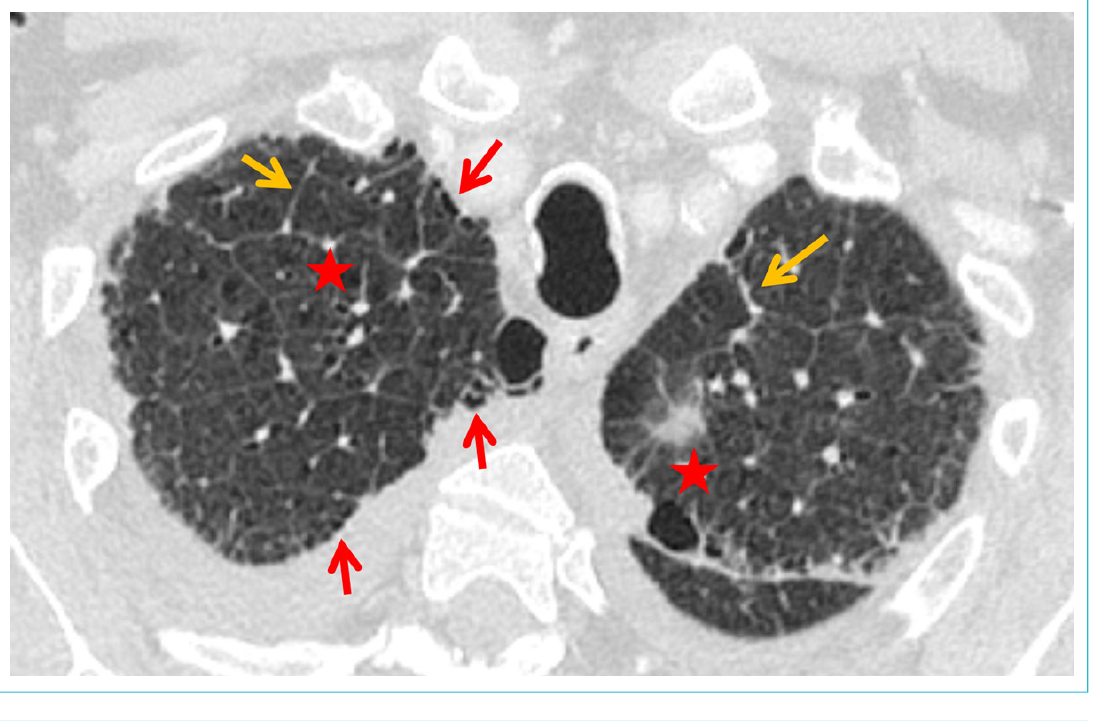
Figure 3: Interlobular septal thickening (orange arrows), slight architectural distortion (asterisks) and a faint honeycombing (red arrows) in a 70-year-old male patient with idiopathic pulmonary fibrosis (IPF).